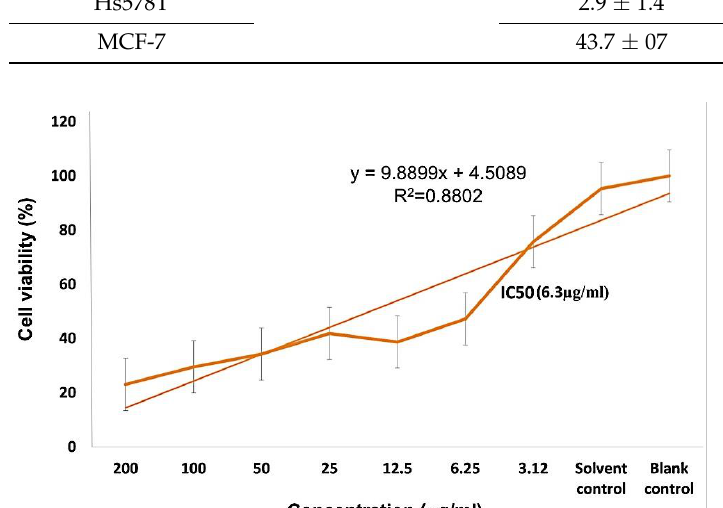
Figure 10. Anticancer activity of ZnO-NPs as a percentage of apoptosis in cell viability on MDA- MB-231 cancer cell line by MTT assay. ( a ) Comparison of DOX, ZnO-NPs, PEG-ZnO-NPs, DOX- ZnO-NPs, and DOX-PEG-ZnO-NPs at different concentration of nanoparticles. ( b ) Comparison of PEG-ZnO-NPs, DOX-ZnO-NPs, and DOX-PEG-ZnO-NPs at different concentration of nanoparti- cles. The results expressed as the ± SD mean subjected to one-way SPSS version. Experiments were performed in triplicate and repeated for three times and the calculated value of p < 0.05.